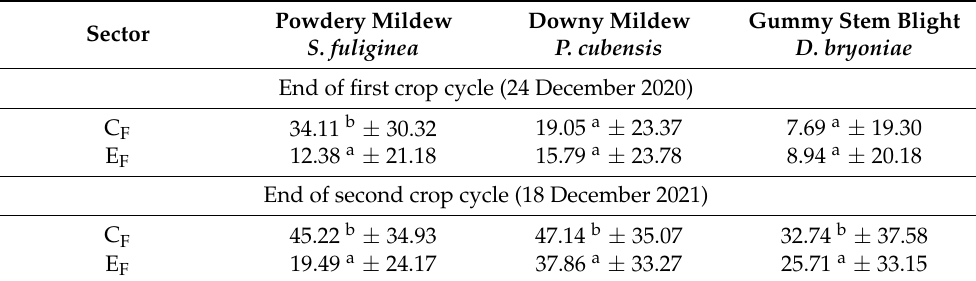
Table 3. Average value of percentage of infection at the end of the trials in both sectors of the experimental greenhouse.